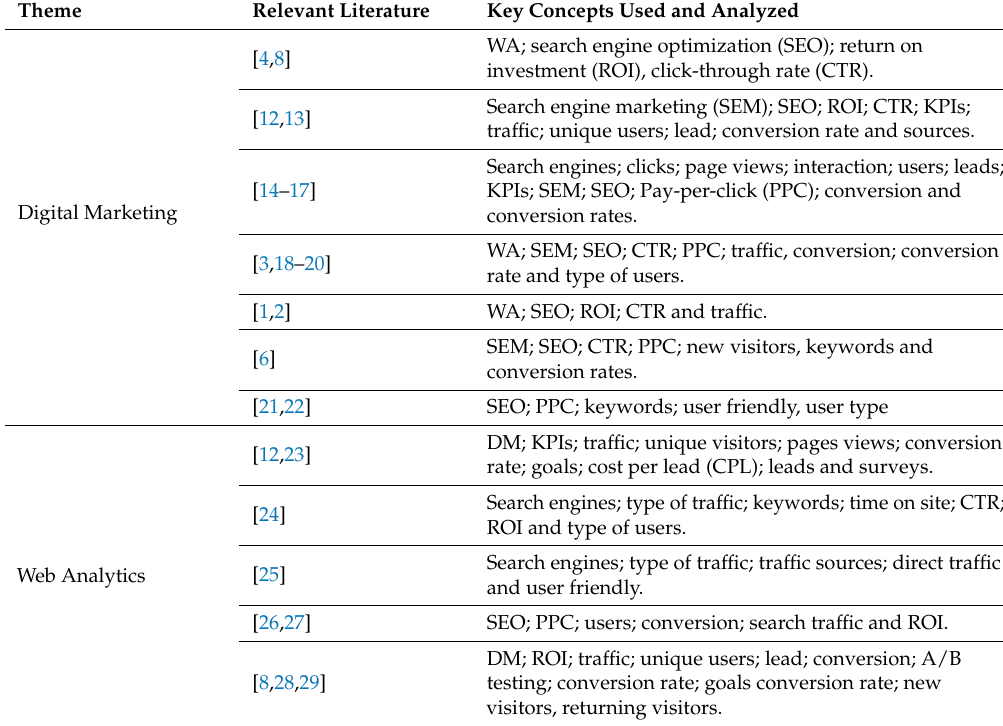
Table 2. Literature review about DM KPI definitions used by relevant